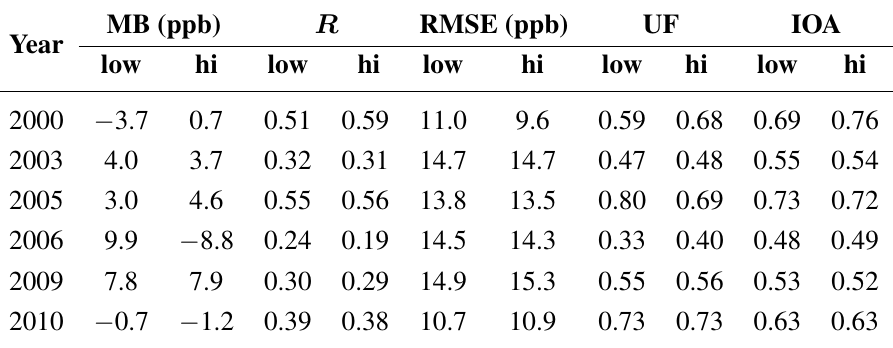
Table 2. Comparison of the hourly model results and the ozone concentrations measured aboard the R. V. Urania; see Section 3.3 for the definition of the Em_low and Em_hi